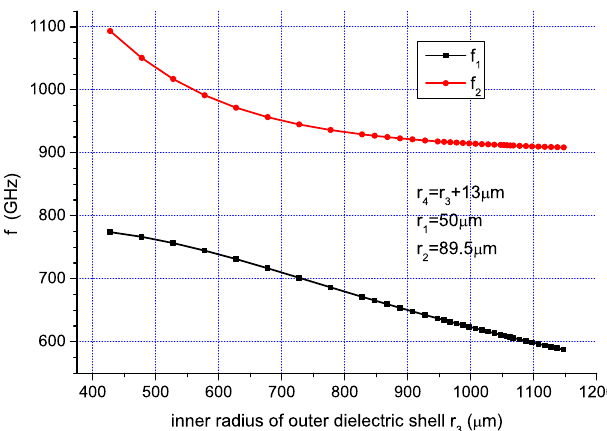
FIG. 8. (Color) Dependence of the first two frequencies of excited modes upon the width of the drive channel. The thick- ness of the outer dielectric shell is fixed and equal to 13 (cid:1) m . The other parameters are as in Table I.